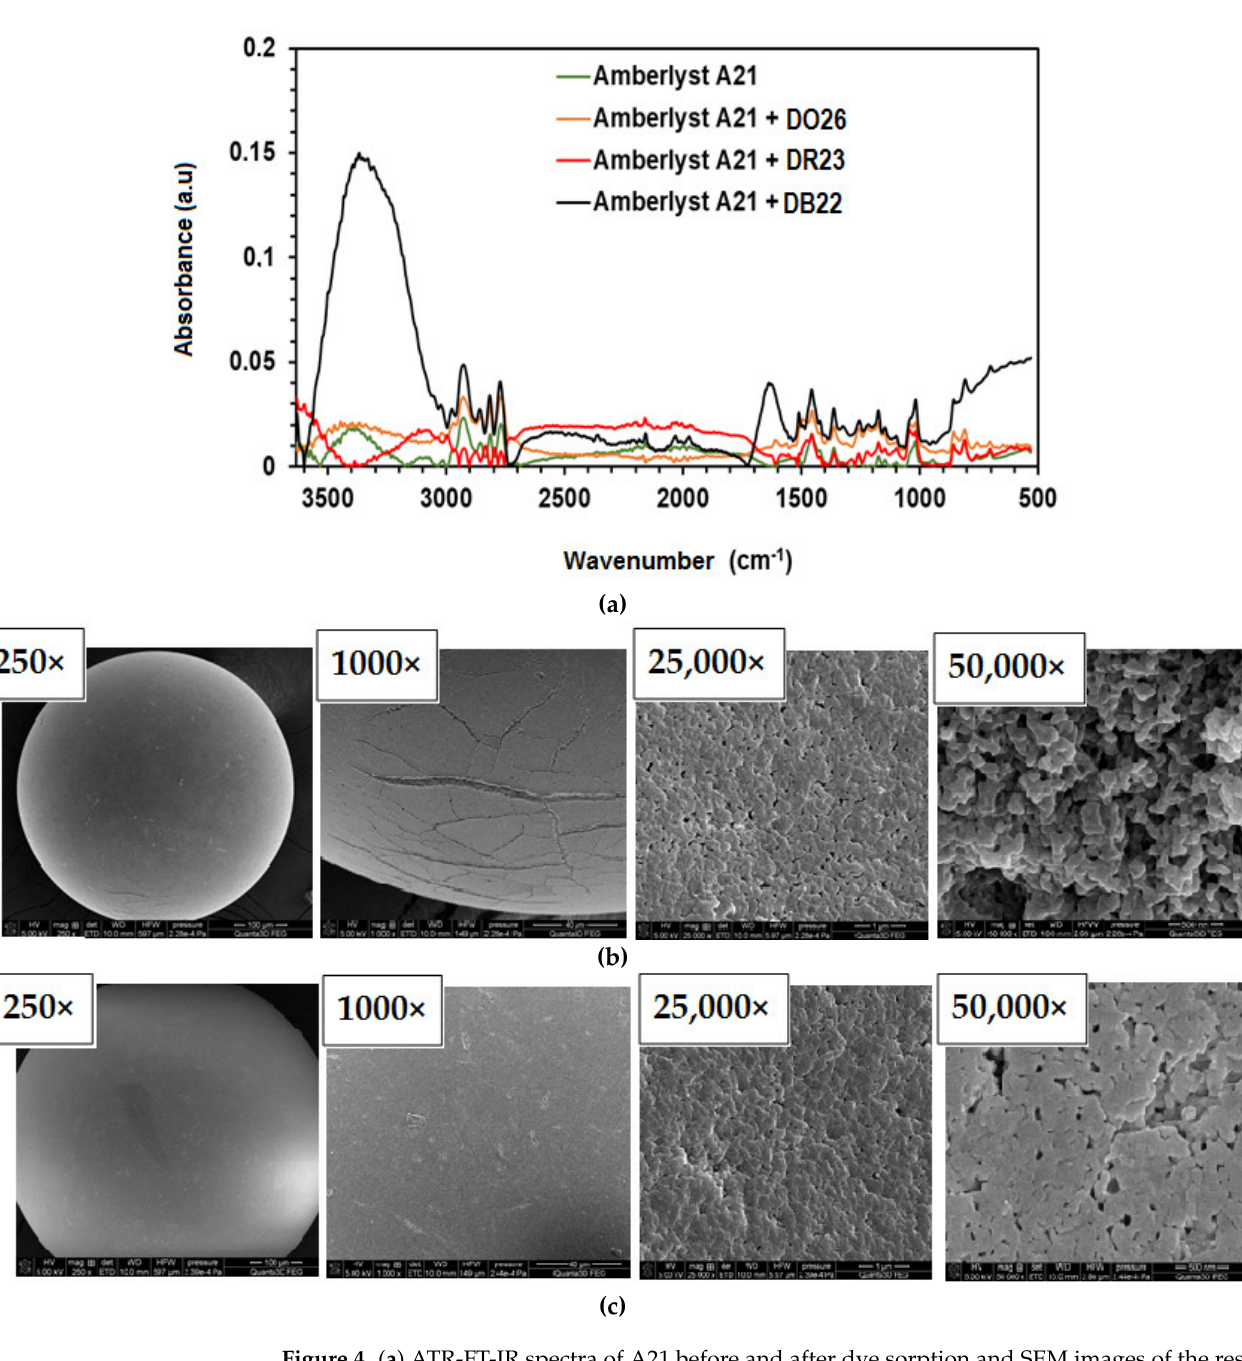
Figure 4. ( a ) ATR-FT-IR spectra of A21 before and after dye sorption and SEM images of the resin ( b ) before and ( c ) after DO26 sorption. The amounts of adsorbed dye at equilibrium under experimental conditions (q e,exp ) were 3.2 mg/g for DB22-A21, 3.3 mg/g for DR23-A21 and 4.3 mg/g for DO26-A21 systems, respectively. According to Marin et al. [28], the amount of DR23 adsorbed by IRA402 and XAD7HP resins significantly increased with the increase of time from 15 to 30 min. During the first 30 min, more than half of the amount of DR23 was retained, and the time required to obtain saturation is 90 min